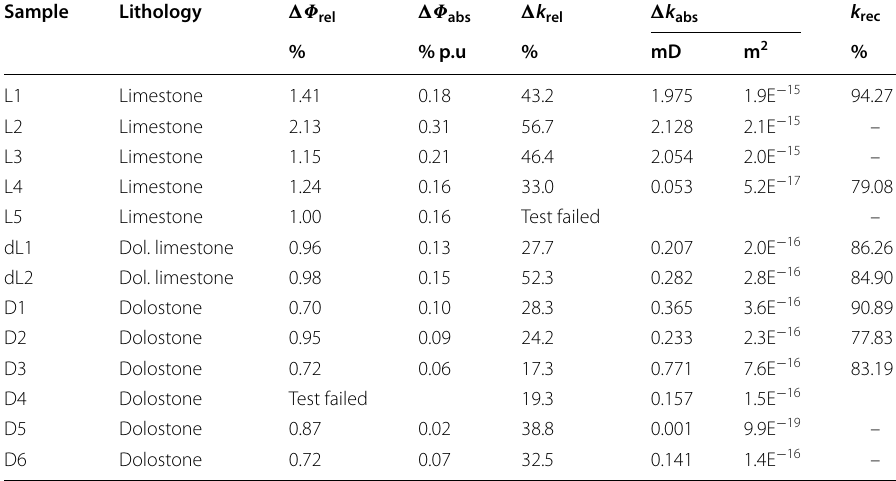
�Φ rel relative porosity reduction, �Φ abs absolute porosity reduction, (cid:31) k rel relative permeability reduction, (cid:31) k abs absolute permeability reduction, k rec permeability